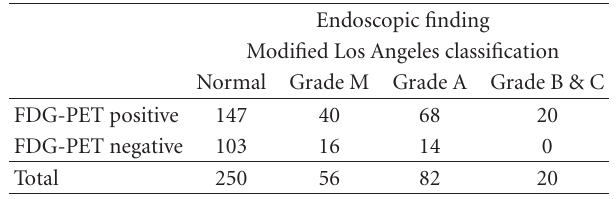
Table 2: Comparative results of the subjects who underwent both FDG-PET and upper gastrointestinal endoscopy.